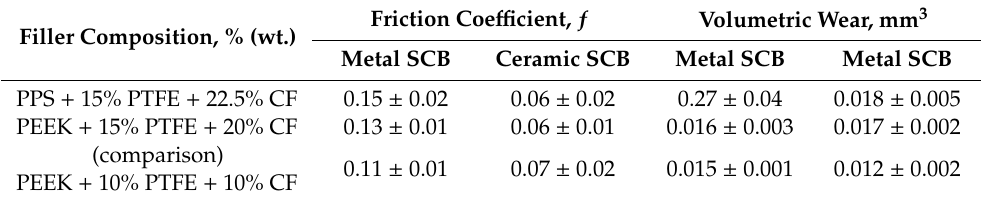
Table 7. Tribological properties of the PEEK- and PPS-based three-component composites with identical degree of filling. Friction Coe ffi cient, Filler Composition, % (wt.)